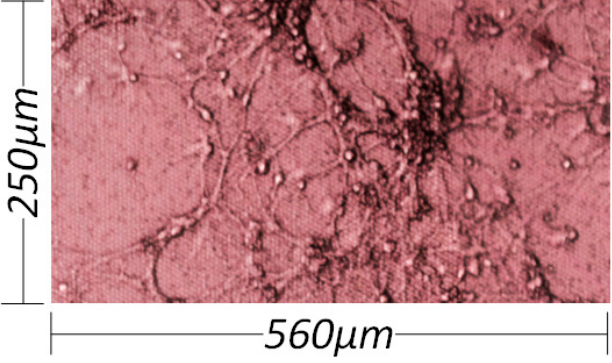
Figure 3. Example of hippocampal neurons culture on the chip.